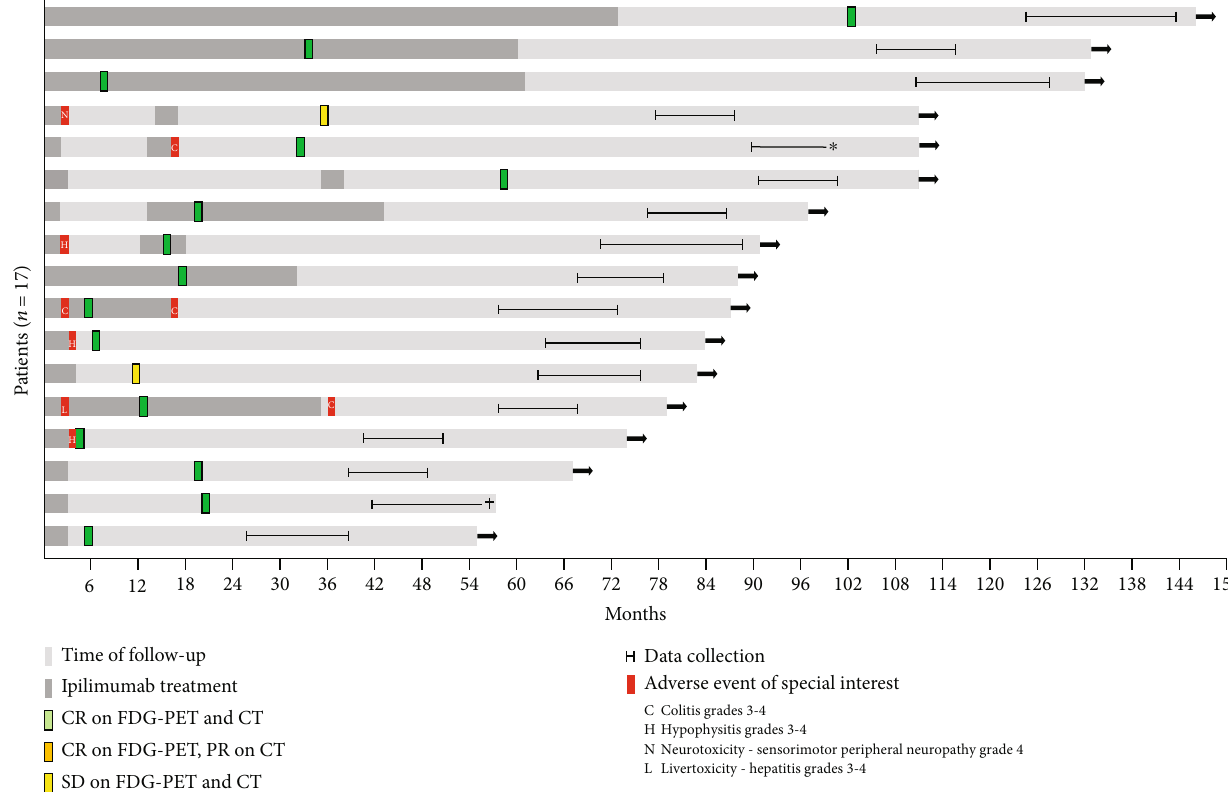
Figure 1: Swimmer plot illustrating duration of IPI administration, date of complete remission (CR), date of stable disease (SD), time of baseline assessment and follow-up, and irAE of special interest. For 2 survivors, no assessment was available at one-year follow-up: one died ( † ) and one had recurrence of metastatic melanoma ( ∗